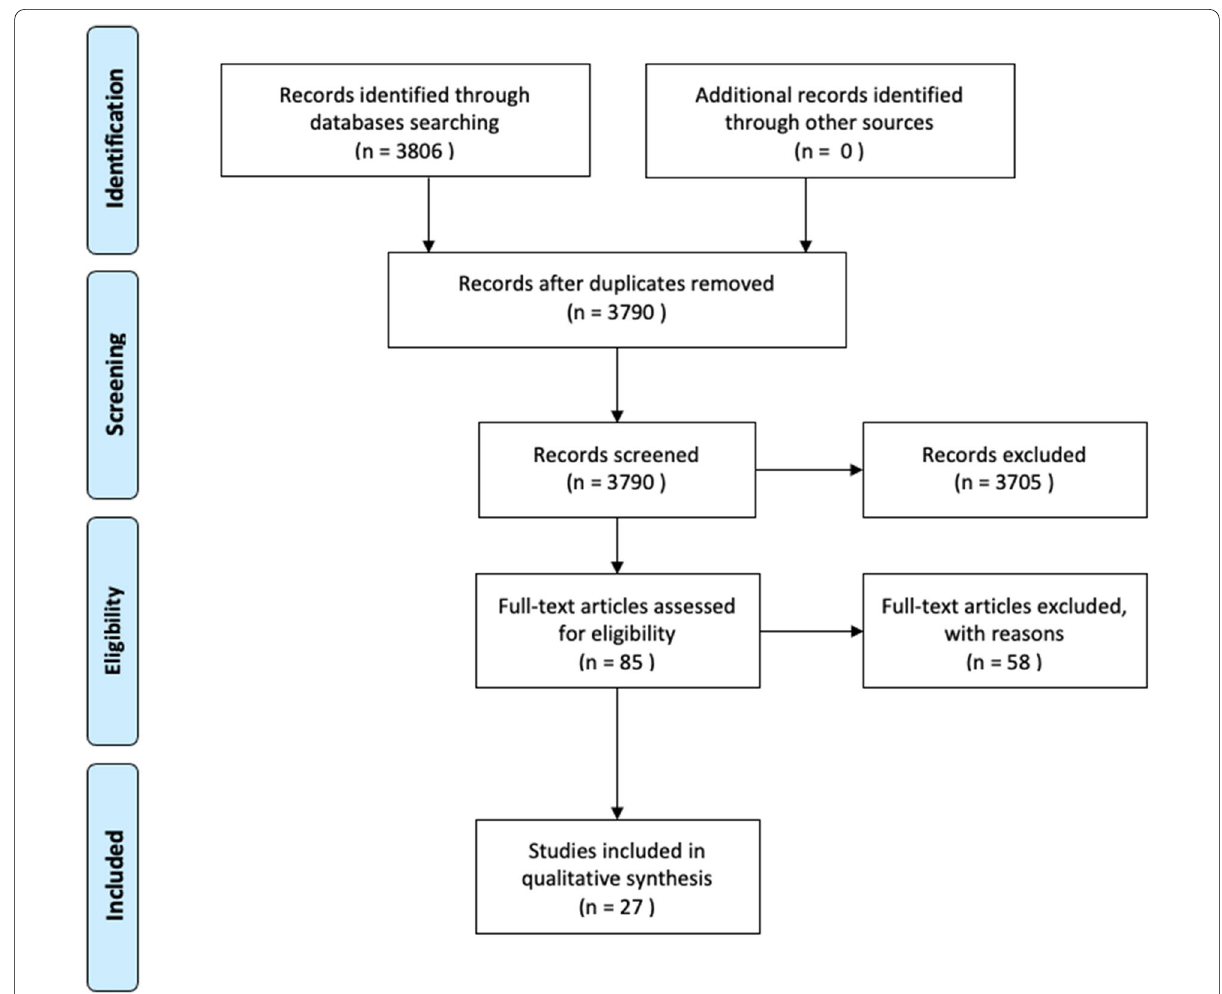
Fig. 2 PRISMA flowchart showing the search for and selection of